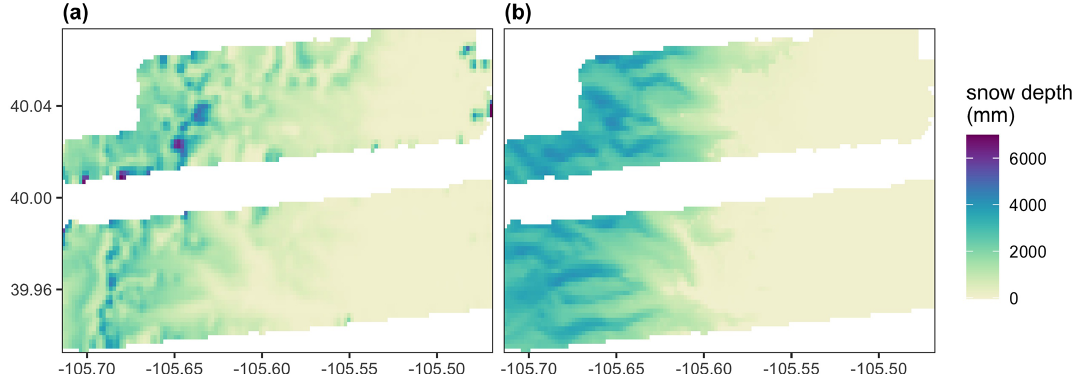
Figure 8. Snow depth on 20 May 2010 in the Boulder Creek Watershed area indicated in Fig. 6 from (a) lidar (described in Harpold et al., 2014) and (b)